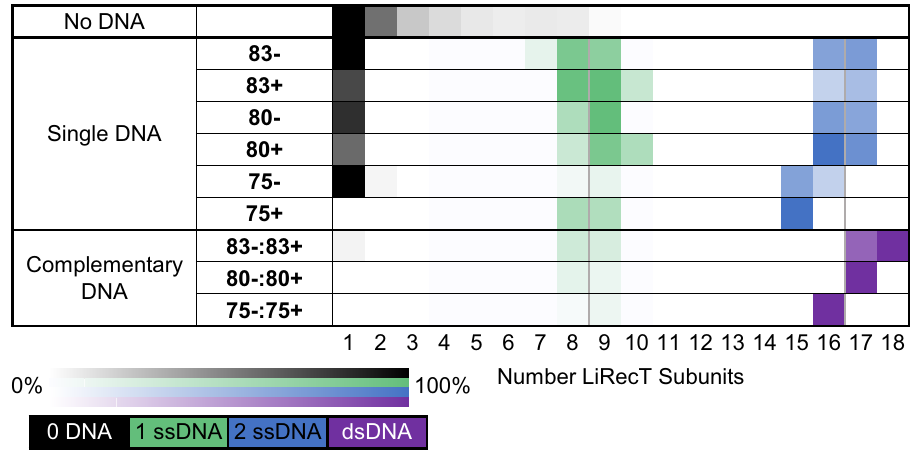
Fig. 6 | Native MS heat maps of LiRecT oligomers formed in solution. The fi rst row (No DNA) shows the oligomers formed by 2 µ M LiRecTin the absence of DNA. Thesecondsetofrows(SingleDNA)showsthespeciesformedaftermixingasingle DNA with 2 µ M LiRecT. The third set of rows (Complementary DNA) shows the species formed after mixing two complementary DNAs sequentially with LiRecT. The order in whichthe DNAsare writtencorresponds to the order of addition. The